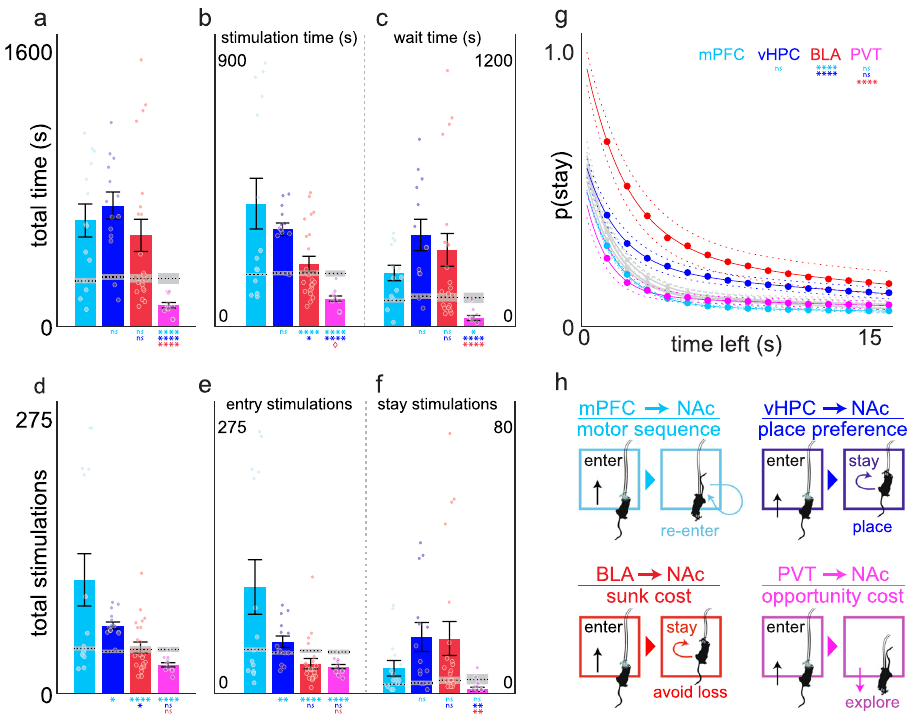
Fig. 5 Direct comparison of optogenetically-induced behavioural strategies across NAcSh inputs. Different NAcSh input groups are depicted by different colours throughout: mPFC → NAcSh (cyan, n = 7 mice), vHPC → NAcSh (blue, n = 7 mice), and BLA → NAcSh (red, n = 11 mice), and PVT → NAcSh (pink, n = 6 mice). a Total time spent in active stimulation zones during testing. mPFC → NAcSh, vHPC → NAcSh, and BLA → NAcSh mice spent similar amounts of time in active zone, while PVT → NAcSh mice spent relatively less time in the active zones. b , c Time spent being actively stimulated (stimulation time, b ) versus waiting during the timeout period (wait time, c ). The relative amount of time spent being stimulated versus waiting differed across inputs. d The total number of stimulation bouts was signi fi cantly higher in mPFC → NAcSh mice compared to other groups, which re fl ects the high number of stimulations by direct zone entry ( e ). In contrast, vHPC → NAcSh and BLA → NAcSh mice earned higher numbers of stay stimulations by prolonged lingering during the timeout period ( f ). g BLA → NAcSh mice were more likely to remain in the active zone throughout the timeout period, distinguishing it from other groups. h Proposed credit assignment functions for each set of NAcSh excitatory inputs. Figures represent pooled data (mean ± SEM) from active corner zones during acquisition and reversal sessions. Mixed-model ANOVAs were used to identify pathway x zone (pooled active or inactive) interactions and Tukey ’ s post hoc tests (outlined in Supplementary Fig. 8) were used for between-pathway comparisons within pooled active zones. Inactive zone data are depicted in Supplementary Fig. 9. Dashed lines represent pooled data from the baseline session and are presented for comparison but were not included in the analysis. * p < 0.05, ** p < 0.01, *** p < 0.001, **** p < 0.0001 versus other pathways as speci fi